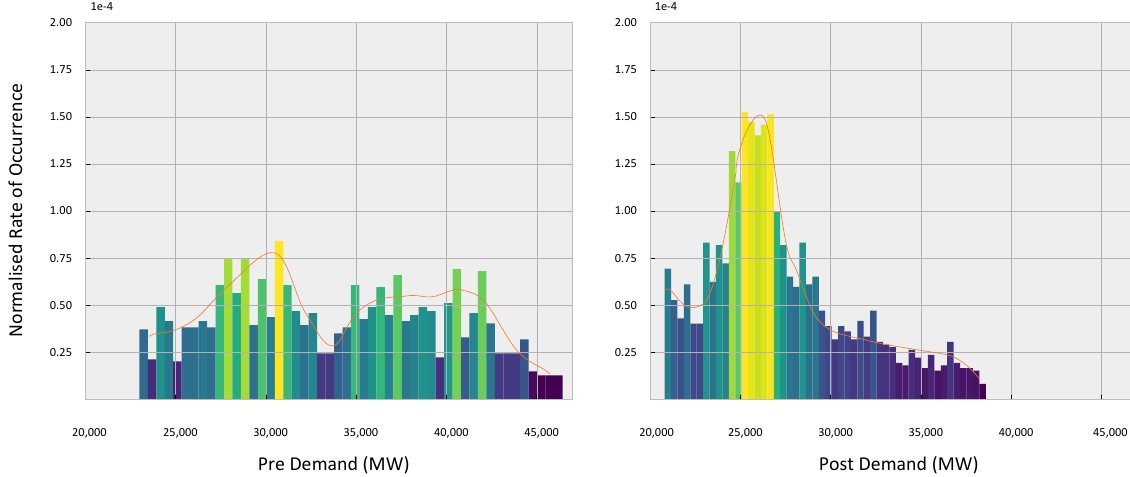
Figure 5. Comparison of pre and post-lockdown demand histograms with normalised occurrences. The range of colours from yellow to dark blue correspond to the highest and lowest values. The post-lockdown shape is smoother and occurrence concentrates only once around 26 MW. Whereas, the pre-lockdown distribution has multiple modes as shown by the running average curve in orange. The plot on the left represents w/c 02/03/20 and the one on the right represents w/c